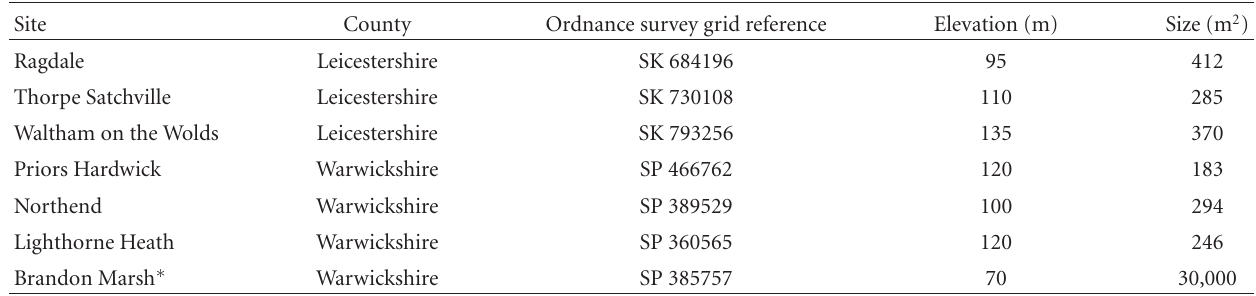
Table 1: Schedule of tertiary treatment and natural reed-bed sites selected for study references for the locations of chosen reed-bed field sites for the invertebrate and botanical diversity study, with features such as elevation and size of